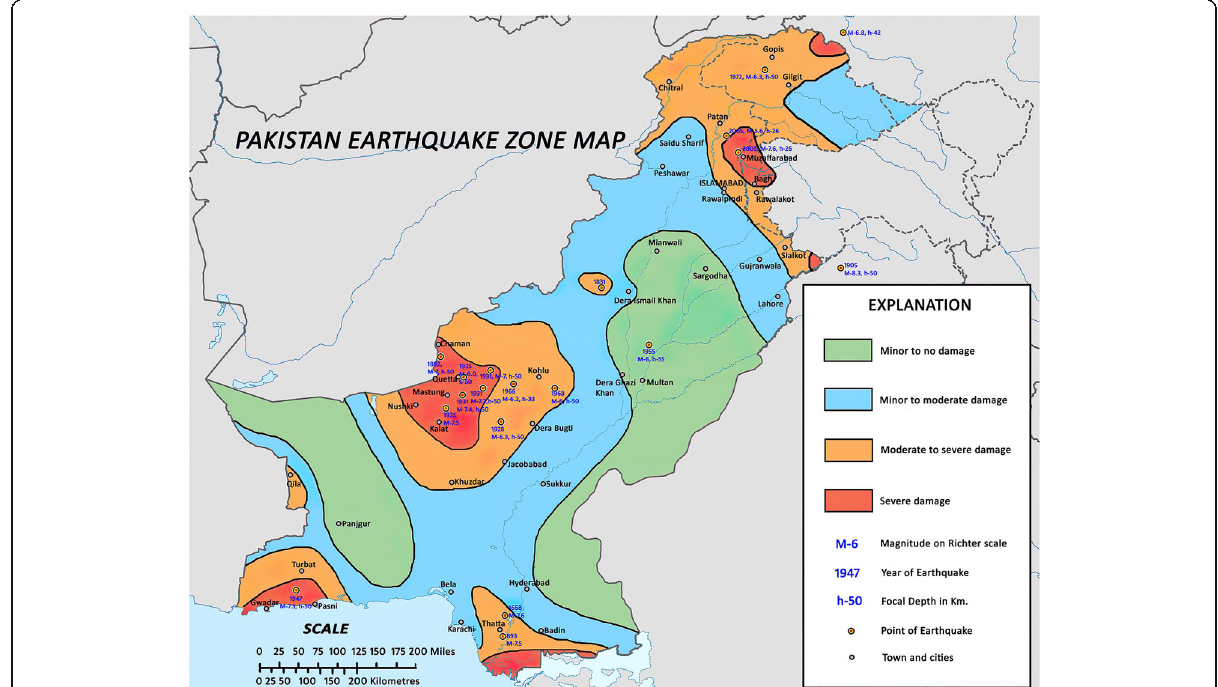
Fig. 1 Seismic hazard map of Pakistan (Center GD